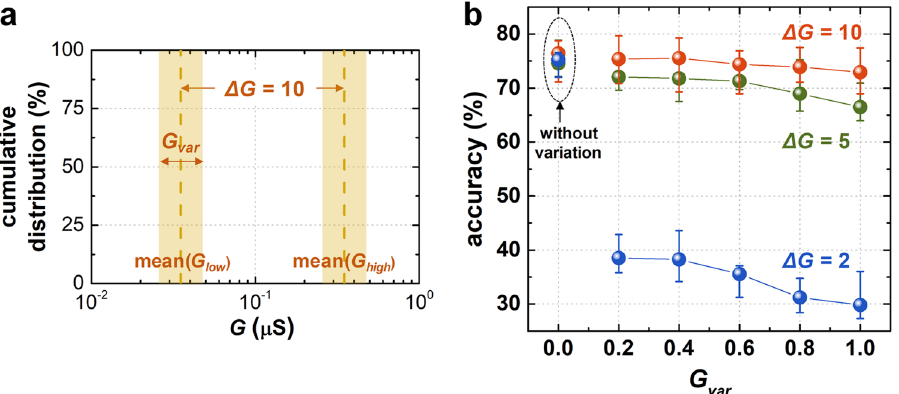
Figure 4. ( a ) The distribution of synaptic device conductance ( G ) in the BNN considering G var . The device conductance of all synaptic devices is determined stochastically within a given G var range during the weight update process. Here, Δ G = mean( G high )/mean( G low ) is fixed to 10. ( b ) The simulated accuracy as a function of G var , which is obtained by repeating the simulation 10